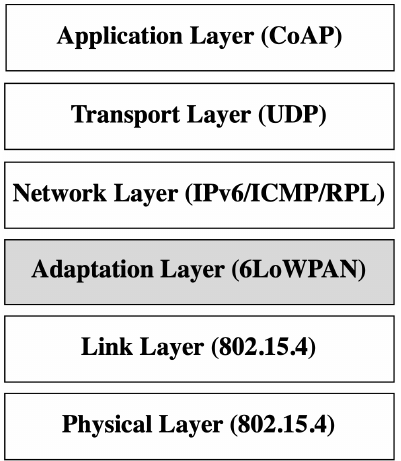
Figure 1. 6LowPAN layers—adapted from